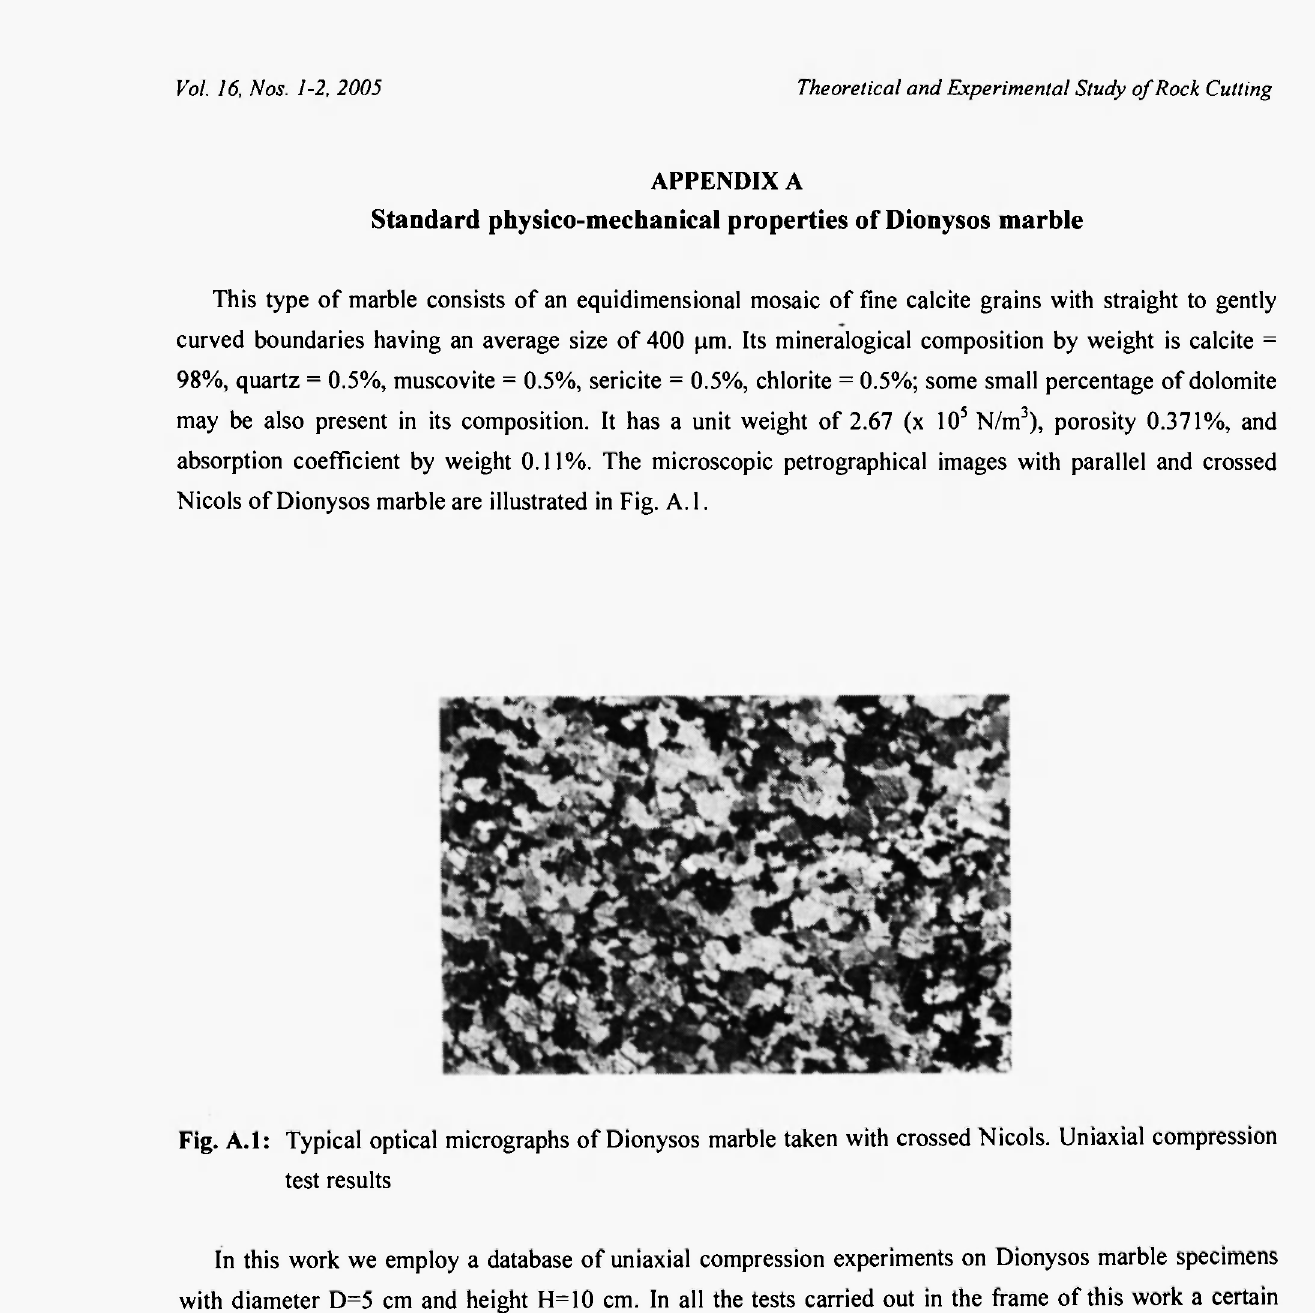
Fig. A.l: Typical optical micrographs of Dionysos marble taken with crossed Nicols. Uniaxial